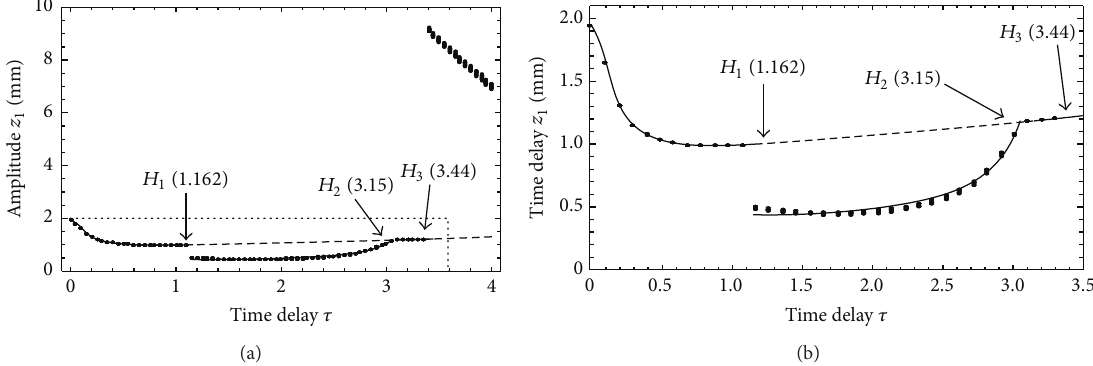
Figure 8: (a) is the amplitude of the master structure under different time delay as the frequency of excitation 𝜔 = 154 rad/s and (b) is the square region in (a). For 𝜏 ∈ (0,1.162) ∪ (3.15, 3.44) , the solid line is stability periodic motion by analysis via Harmonic Balance Method (HBM), and for 𝜏 ∈ (1.162, 3.15) , the solid line is obtained via Multiscale Method (MSM). The dashed line is unstable motion obtained by HBM and the dots are the results by numerical simulation.